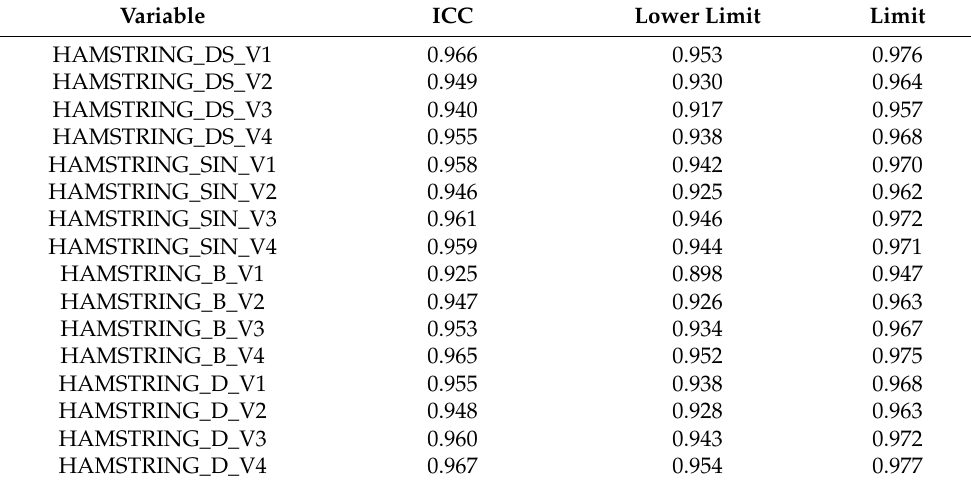
Table A2. ICC Reliability Chart (95%) of the three repeated measurements of EMG variables for